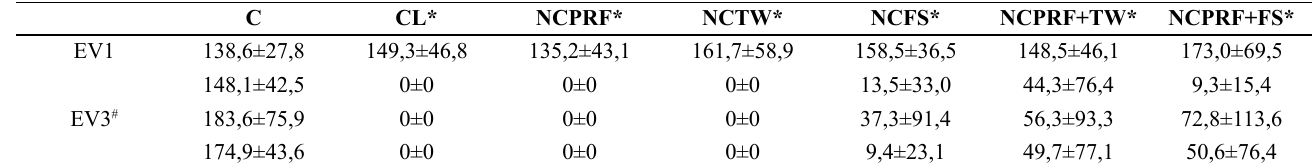
Table 1. Presentation of the numerical data, on average and standard deviation, of the gripping force (g). The groups (absolute control (C), control lesion (CL), Nerve compression and PRF (NCPRF), Nerve compression and treadmill walking (NCTW), Nerve compression and free swimming (NCFS), Nerve compression, PRF and treadmill walking (NCPRF+TW) and Nerve compression, PRF and free swimming (NCPRF+FS)) are pre - sented in columns and the evaluations (evaluation 1 (EV1), evaluation 2 (EV2), evaluation 3 (EV3) and evaluation 4 (EV4)) in the different lines. C CL* NCPRF* NCTW* EV1